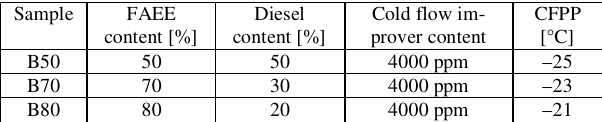
Table 4. Cold flow properties of the fuel containing FAEE and mineral Diesel fuel with cold flow improving additives